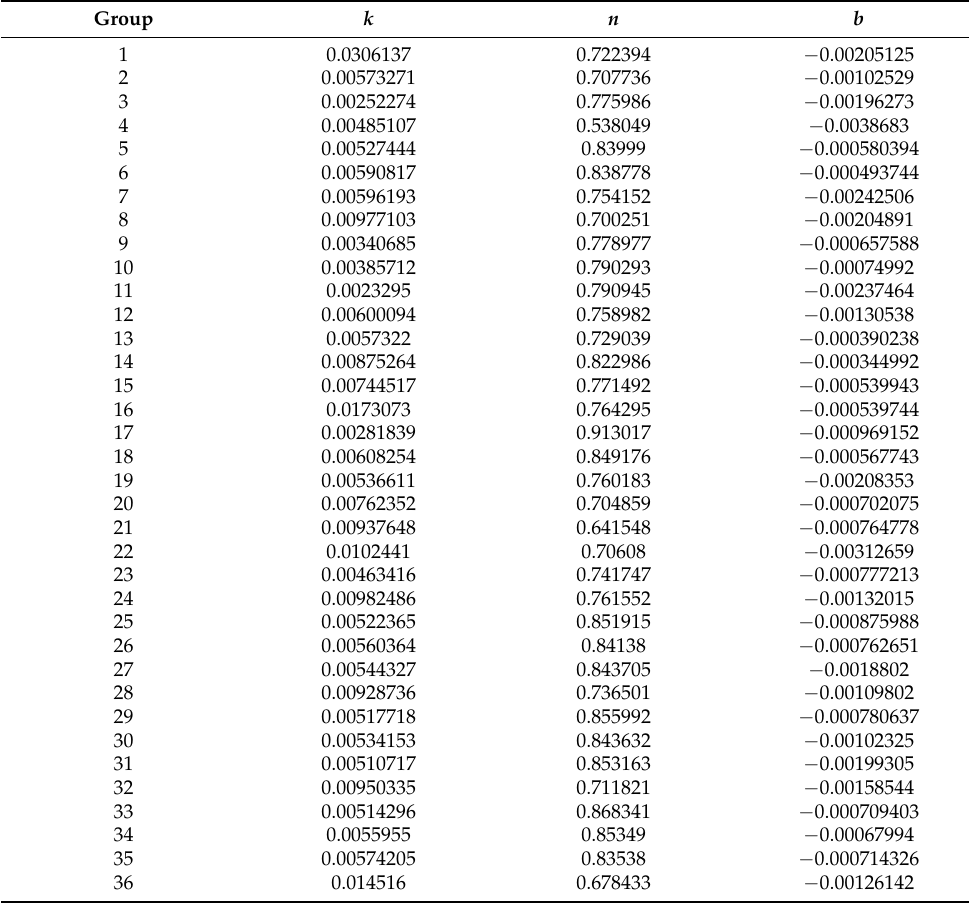
Table 7. Coefficients of AT-MR